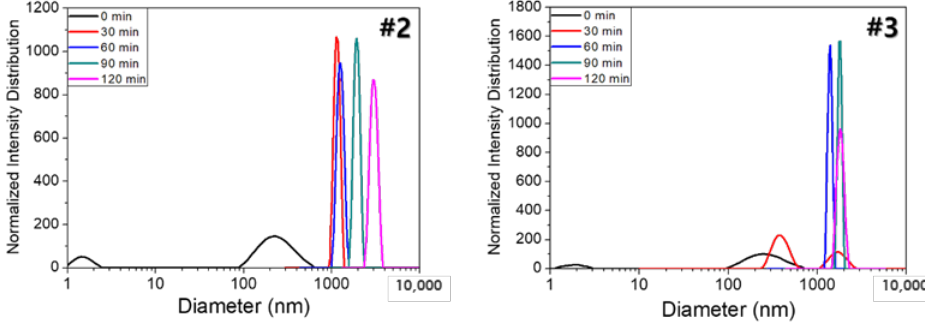
Figure 6. A dynamic light scattering of the GA/#2 ( left ) and GA/#3 ( right ) with incubation time. Table 4. Average sizes of the particles formed in the GA/#2 and GA/#3 with incubation time. Average Particle Sizes (nm) Time (min)